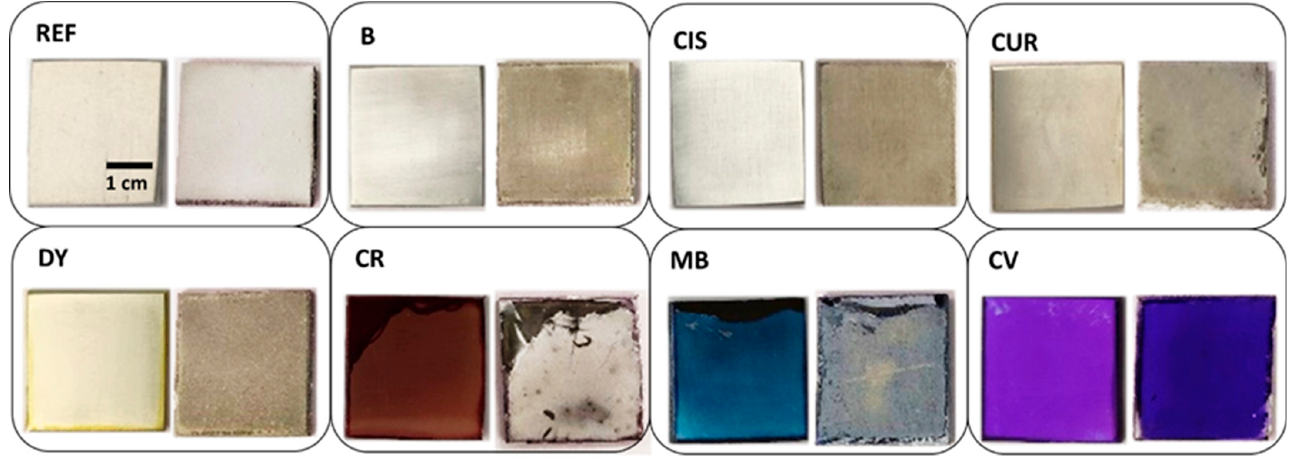
Figure 3. Overview picture of sol-gel coated samples before (left) and after (right) the corrosion test.